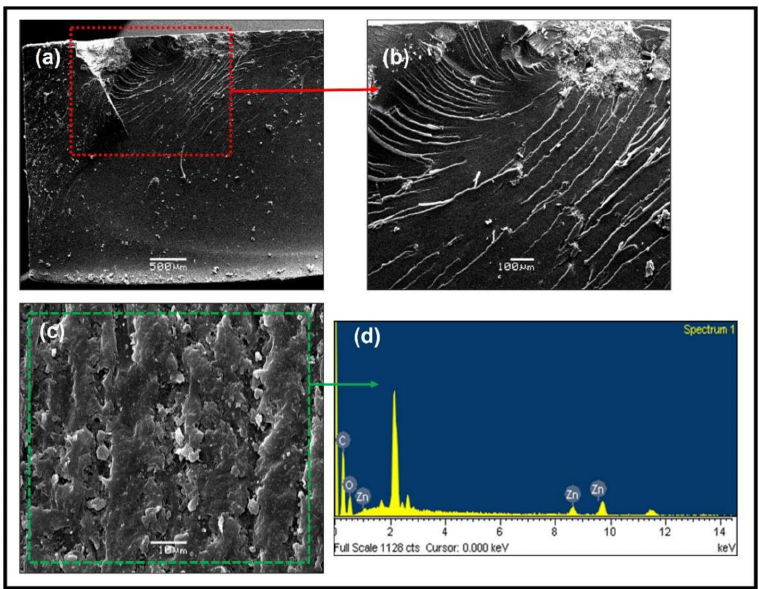
Figure 11. ( a , b ) SEM analysis of the fracture of hybrid materials (HMF1), ( c , d ) SEM microscopy of the analyzed surface and EDS